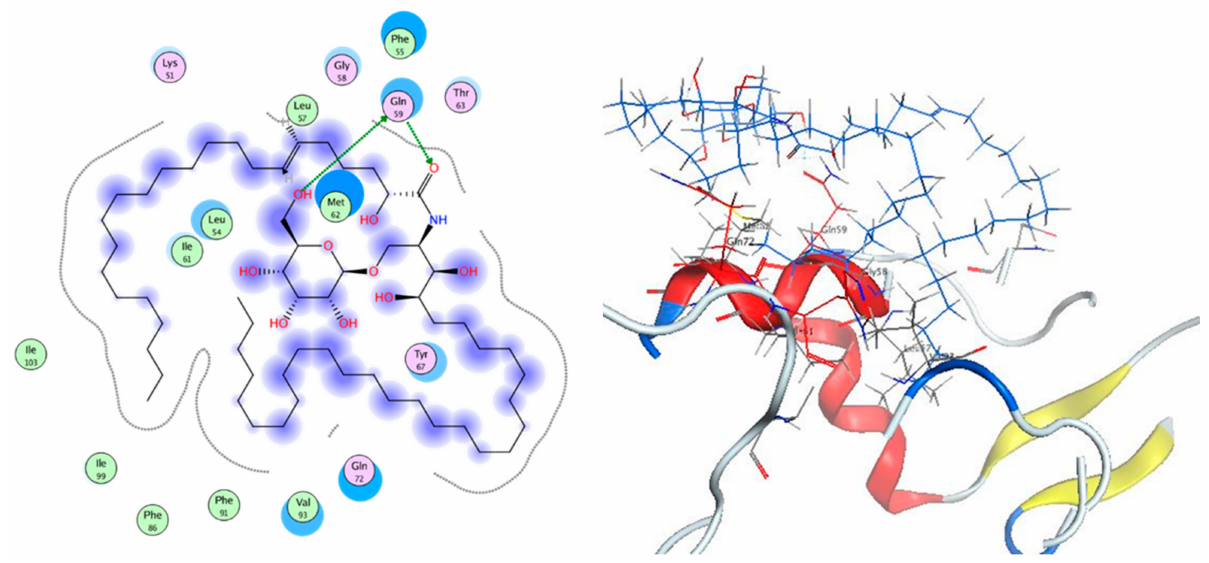
Figure 6. 2D and 3D captions of compound 1